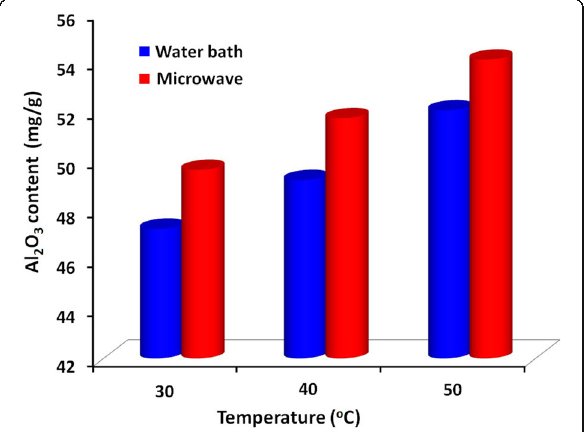
Fig. 1 Aluminum contents of hide powder tanned at 30 °C, 40